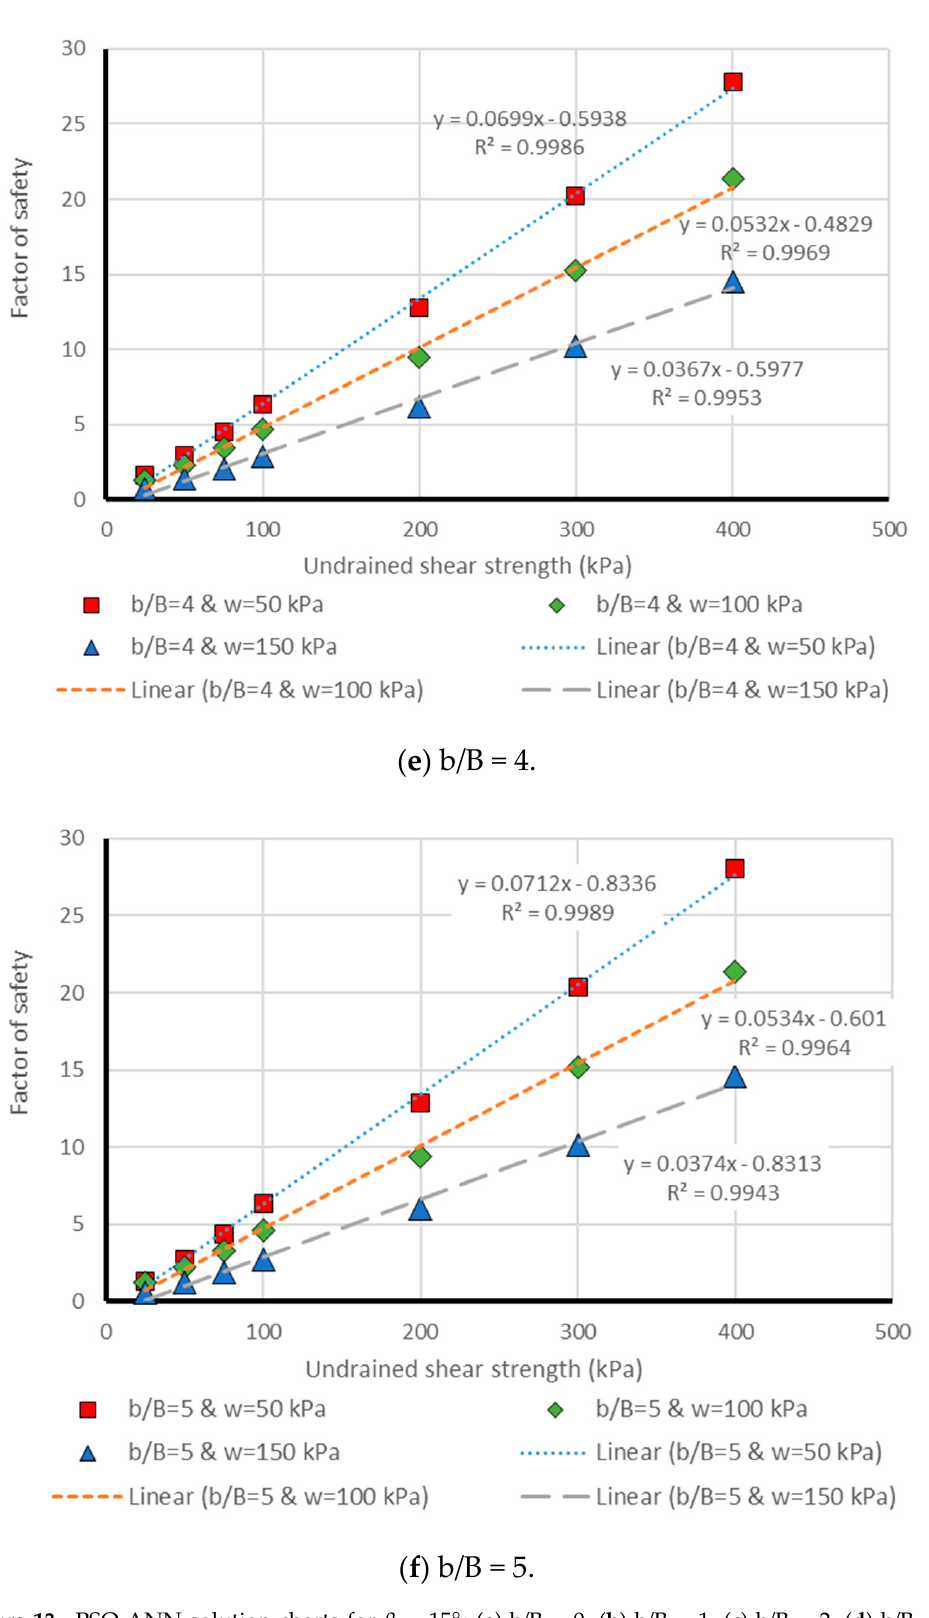
Figure 13. PSO-ANN solution charts for β = 15 ⁰ ; ( a ) b/B = 0, ( b ) b/B = 1, ( c ) b/B = 2, ( d ) b/B = 3, ( e ) b/B = 4, and ( f ) b/B = 5,